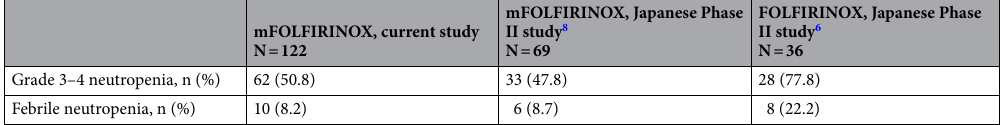
Table 2. Incidence of severe neutropenia of current and previous study.